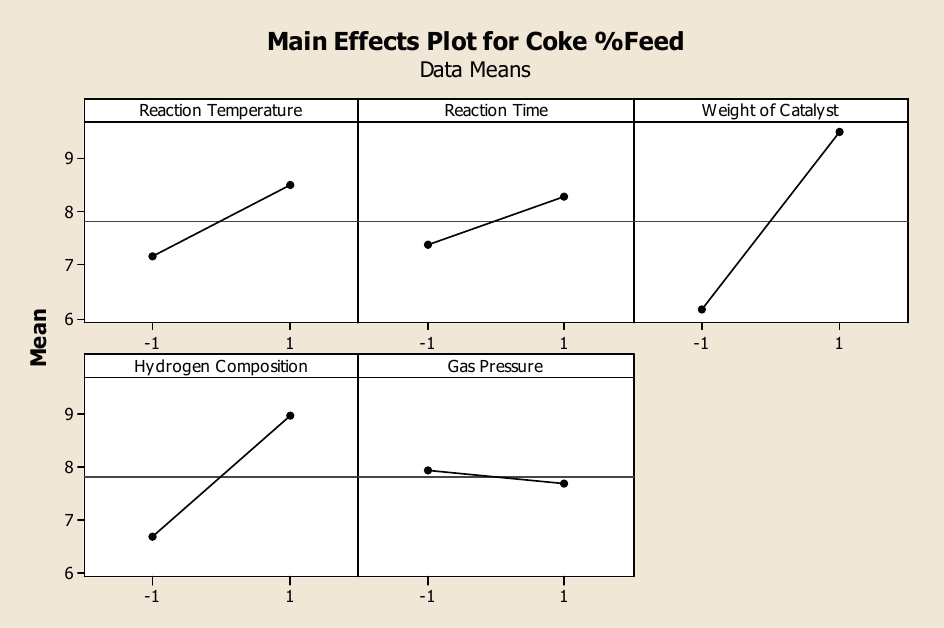
Figure 4. Main effects plot for